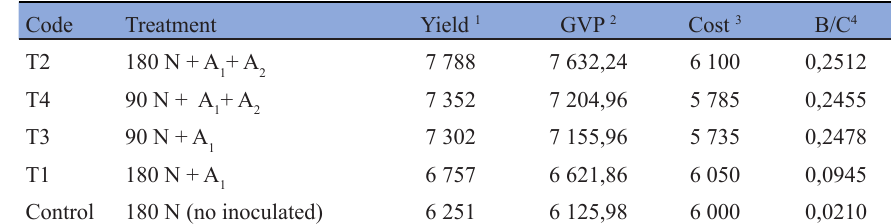
Table 4. Grain yield and benefit-cost ratio per hectare